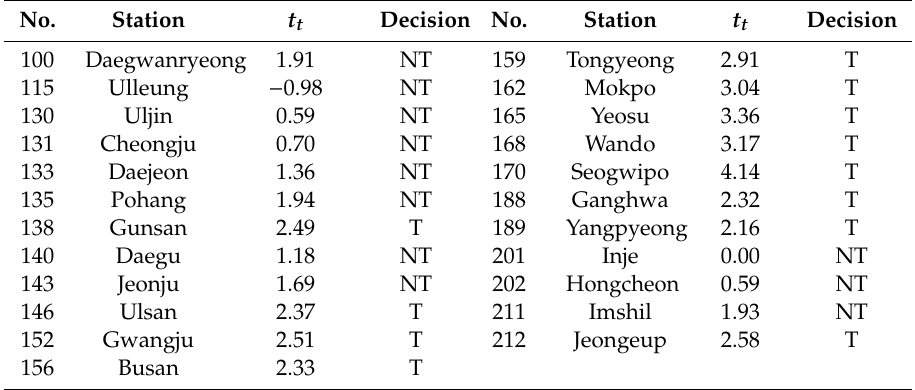
Table 7. Spearman rank correlation analysis of annual precipitation using climate change